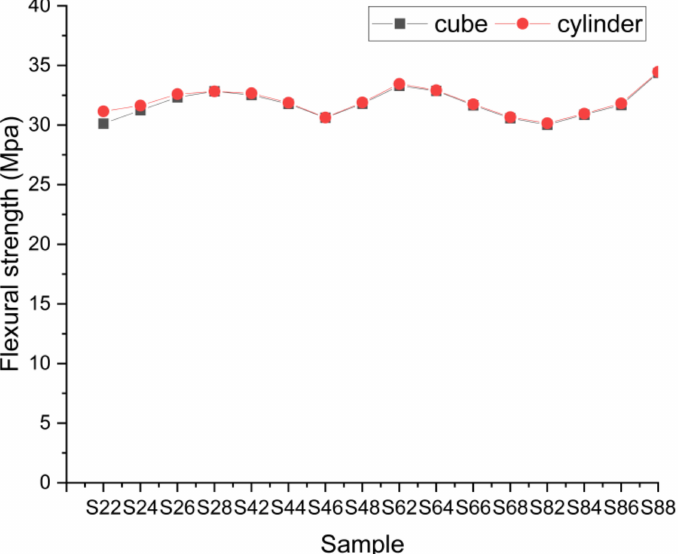
Figure 9. Flexural strength